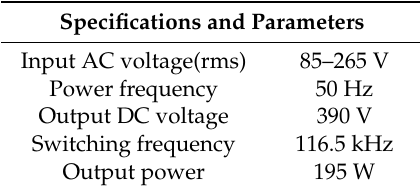
Table 1. PFC converter specifications and parameters.